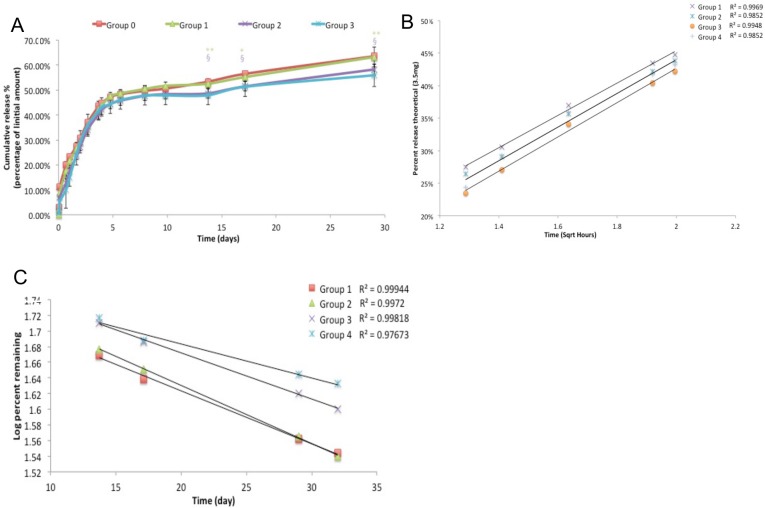
Drug release profile of cements.The release profile of cylindrical composites in PBS, over 30 days (A) (*, § indicate p< 0.05, **, §§ indicate P<0.01, Dunnet’s t-test). The first 4 days, or 45%, of release plotted using the Higuchi model (B). After 14 days the release rate closely matched first order release (C).